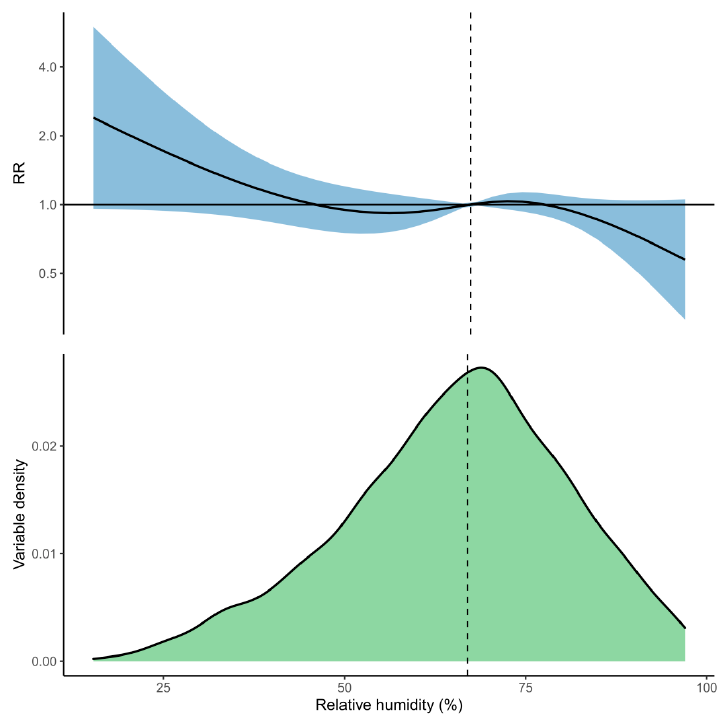
Figure 5. The top panel shows the cumulative association between relative humidity and pneumonia hospital admissions across a 21-day lag period. The solid curve is the predicted relative rates (RR), and the shaded region is the 95% CI. The lower panel shows the distribution of relative humidity within the iDEWS dataset. The median relative humidity (67%) is indicated by the dashed vertical line and is used as the reference value against which the RR for other relative humidity values is compared.